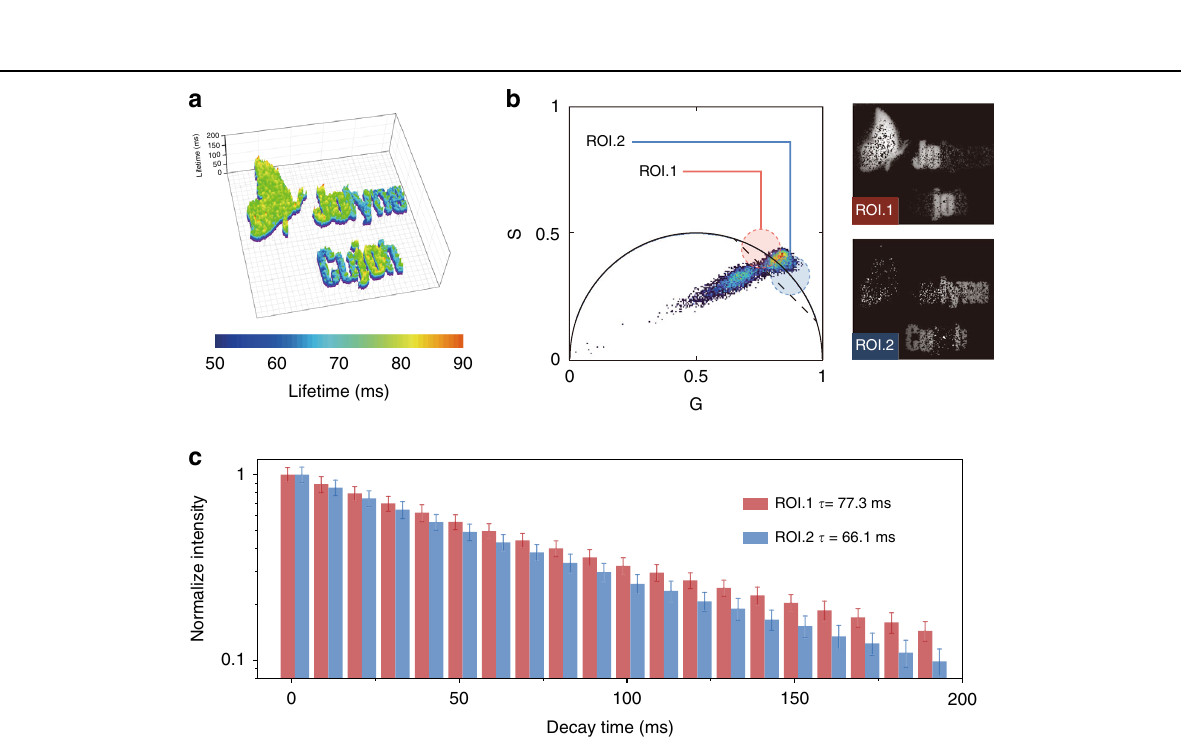
Fig. 5 The design of highly con fi dential steganography based on the grayscale DURTP of halogen-doped CDs composite. a The physical and informational structures of the steganographic device. b Photographs of the activated steganographic device under room light and after UV light was switched off. Note that the whole device is transparent and highly fl exible. c Scheme for the cycle of “ write/read/burn-after-read/reset ” of the dynamic layer. d Photographs of the steganographic device at different stages in the encryption